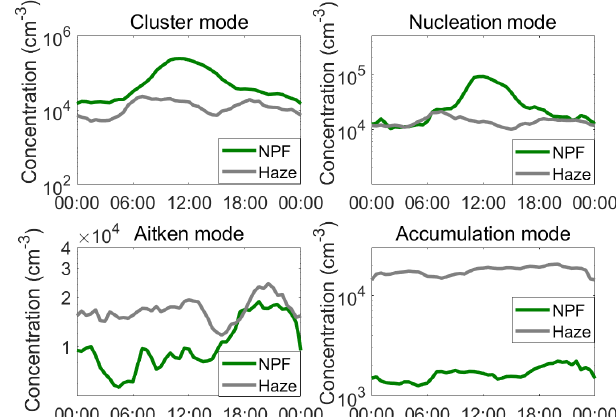
Figure 7. Diurnal variation of particle number concentration of ev- ery mode (cluster, nucleation, Aitken and accumulation mode sepa- rately) on the NPF event days (green lines) and the haze days (gray lines). The time resolution was 30min for every data point. Every data point here represents the median of all data at the same time of the